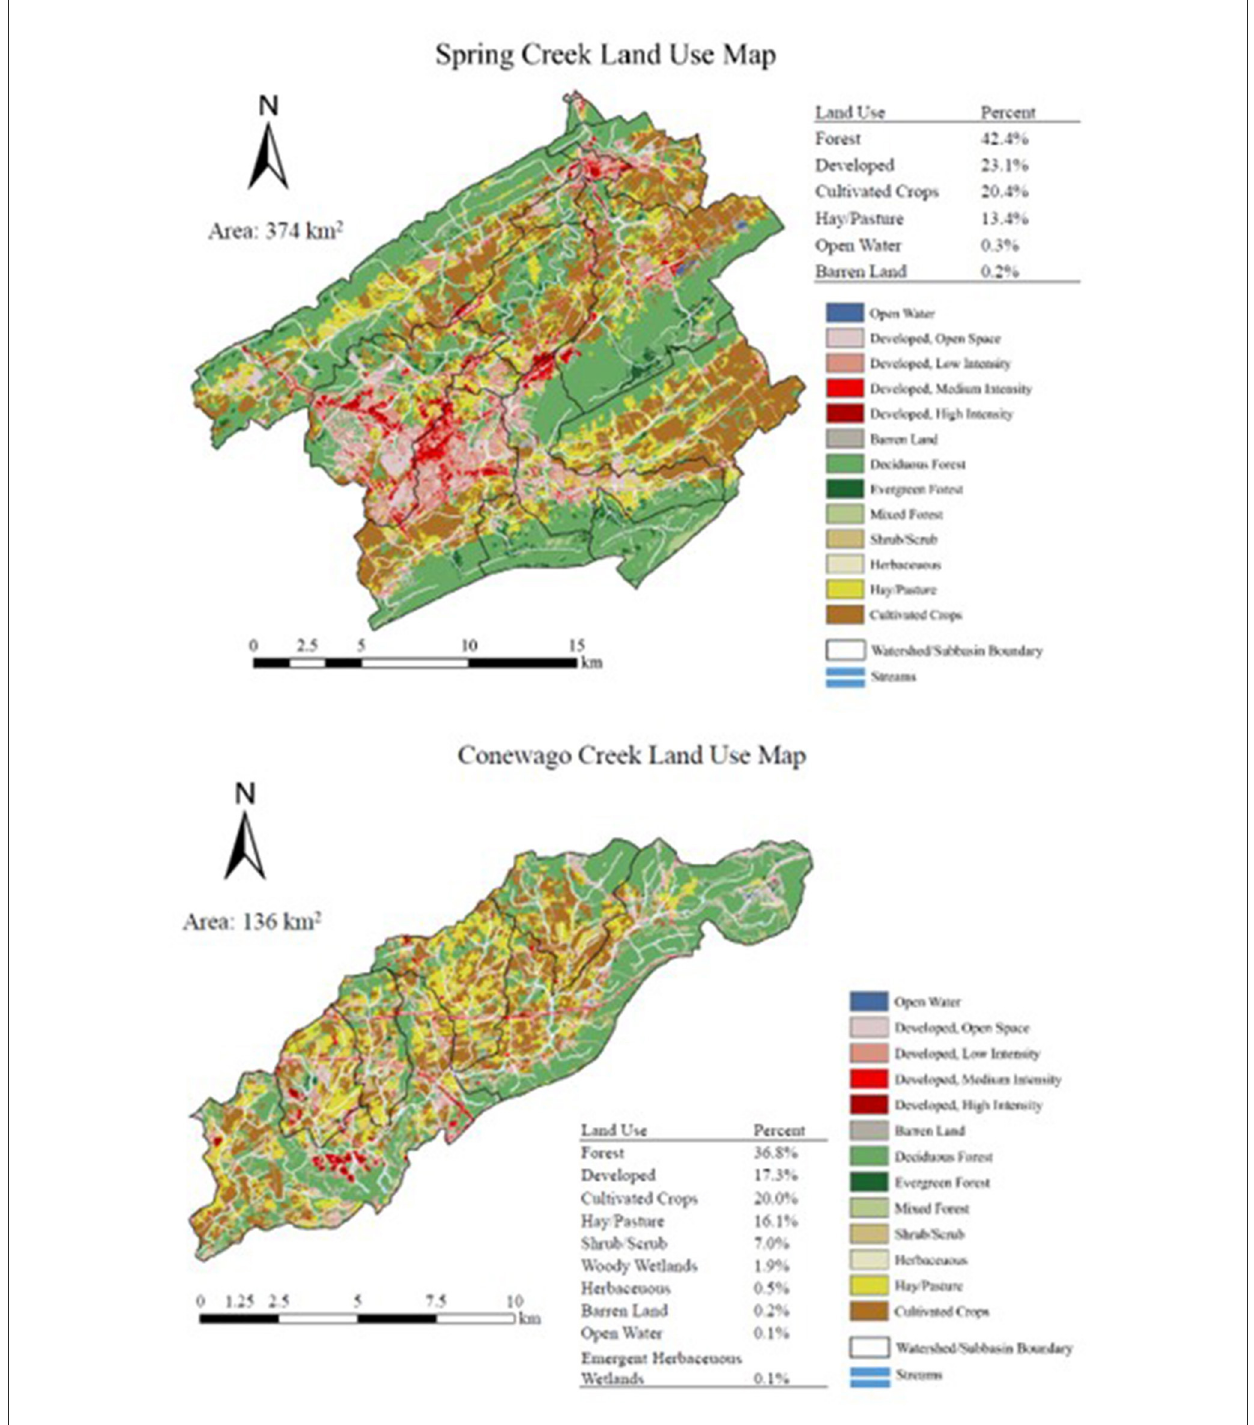
FIGURE2 Spring Creek land use map and Conewago Creek land use map. Both regions are part of the Susquehanna River Basin and have been a key focus area for the Chesapeake Bay scholars on the team.